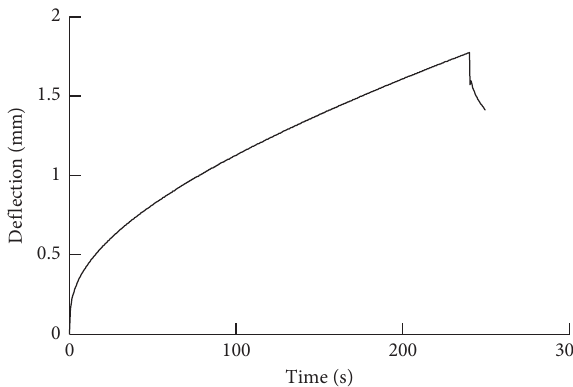
Figure 2: Loading time-deflection figure of BBR asphalt